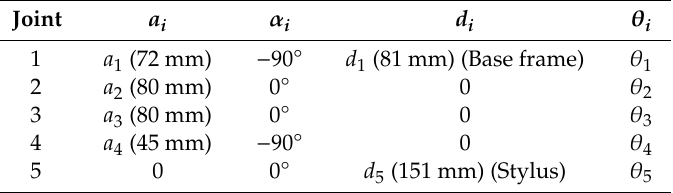
Table 1. Denavit–Hartenberg (D-H)